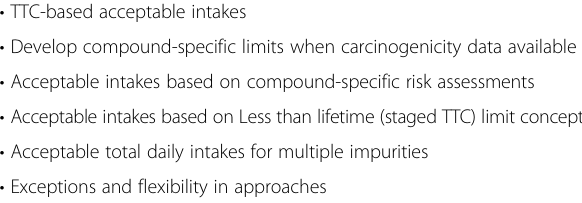
Table 3 Risk characterization for acceptable intake